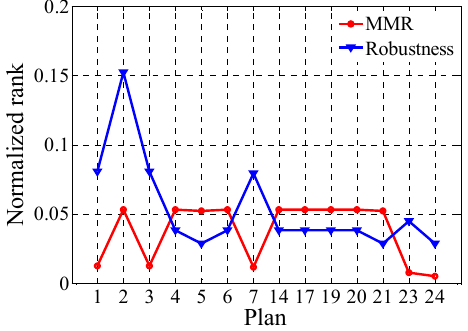
Figure 6. Risk analysis of different plans.